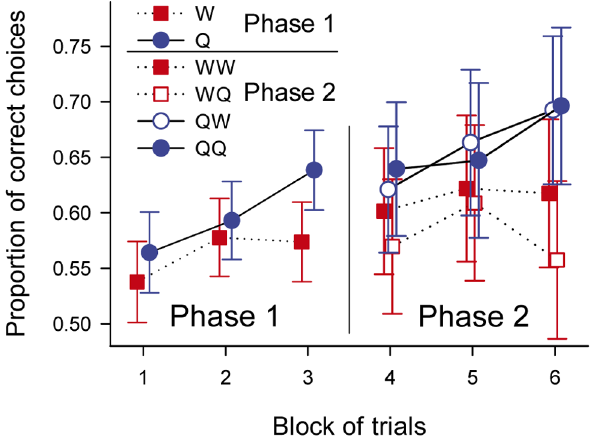
Figure 5. Learning performance. Average proportion of correct choices (estimated for the mean choice latency) over a block for bees which had water (red squares) and quinine (blue circles) as the negative reinforcer (US- 1 ) during phase 1. For blocks 4–6, filled symbols correspond to bees which had the same reinforcer in phases 1 and 2 of the experiment, and empty symbols to bees which had different reinforcers. Error bars denote 95% confidence intervals.